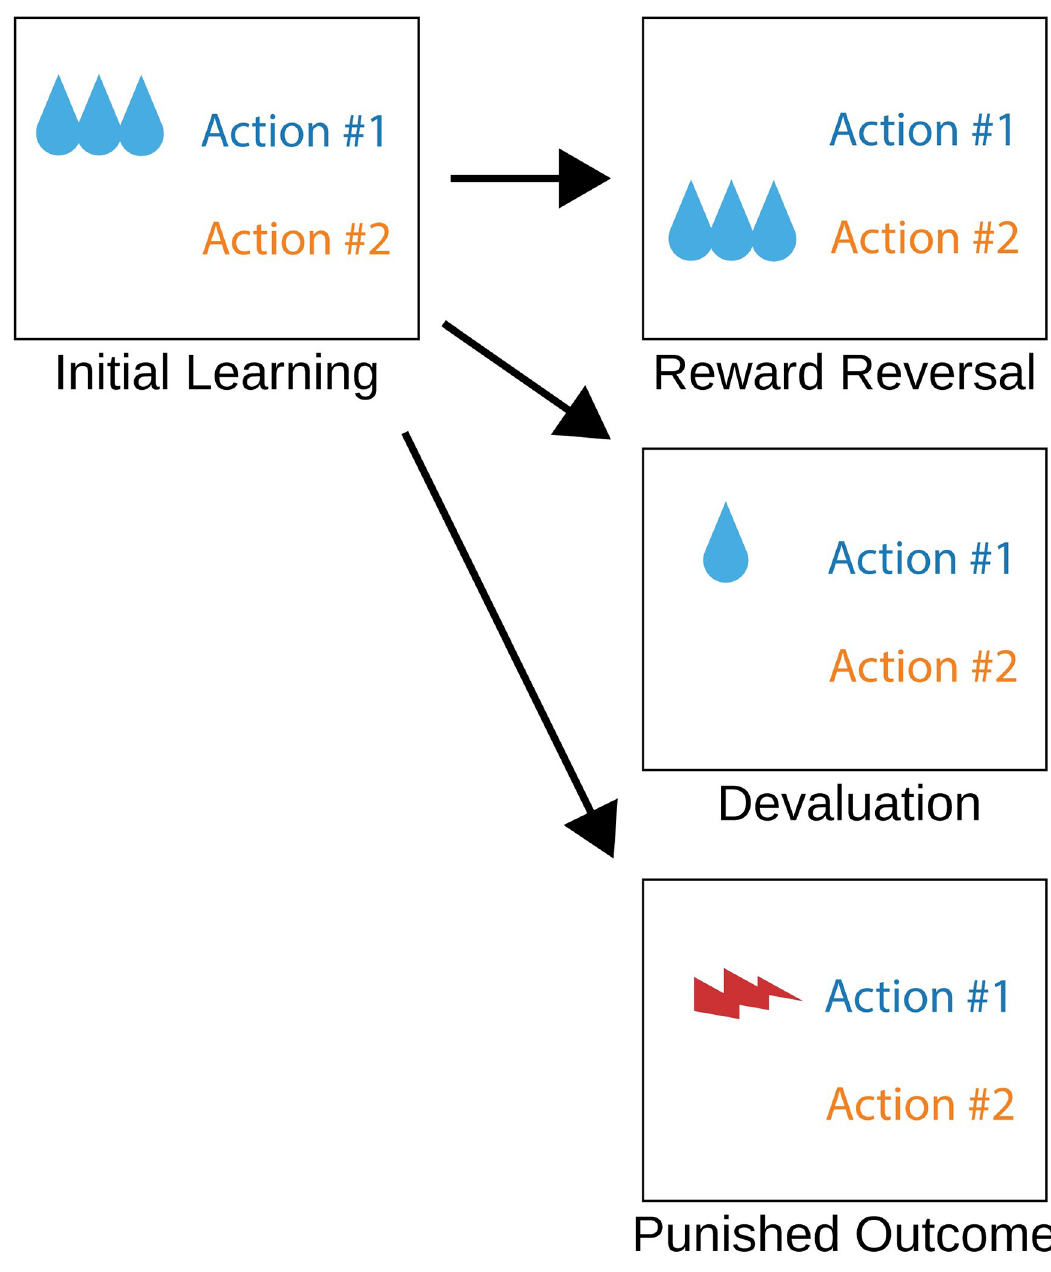
Fig 1. Diagram of simulated behavioral sessions. Model instances were trained with reward feedback that was specific to the behavioral session. The three other types of behavioral sessions each began after being trained by an initial learning session such that in the reward reversal, devaluation, and punished outcome sessions, the model instance was already trained to select action #1. the DLS. Each partition also contains a direct and indirect pathway for each of the two behav- ioral choices that are presented to the agent. Each partition engages the machinery of the BG to utilize input from cortex, and the processing of this input modulates inhibition back onto the cortex in a way that reflects the accumulation of past experience in cortico-striatal weights. By implementing different synaptic weight update rules in the DMS and DLS, different modes